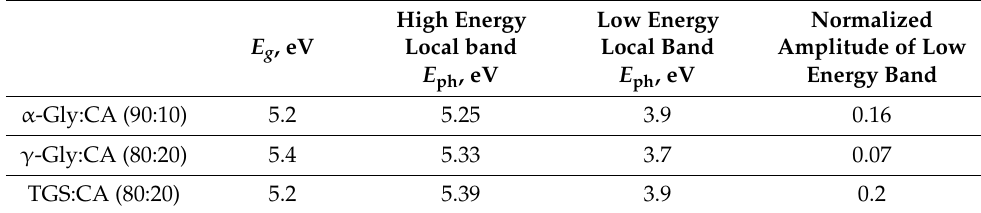
Table 10. Energy gap E g , eV, photon energy E ph of high- and low-energy local bands and normalized amplitude of low energy band in absorption spectra of α -Gly:CA (90:10), γ -Gly:CA (80:20)